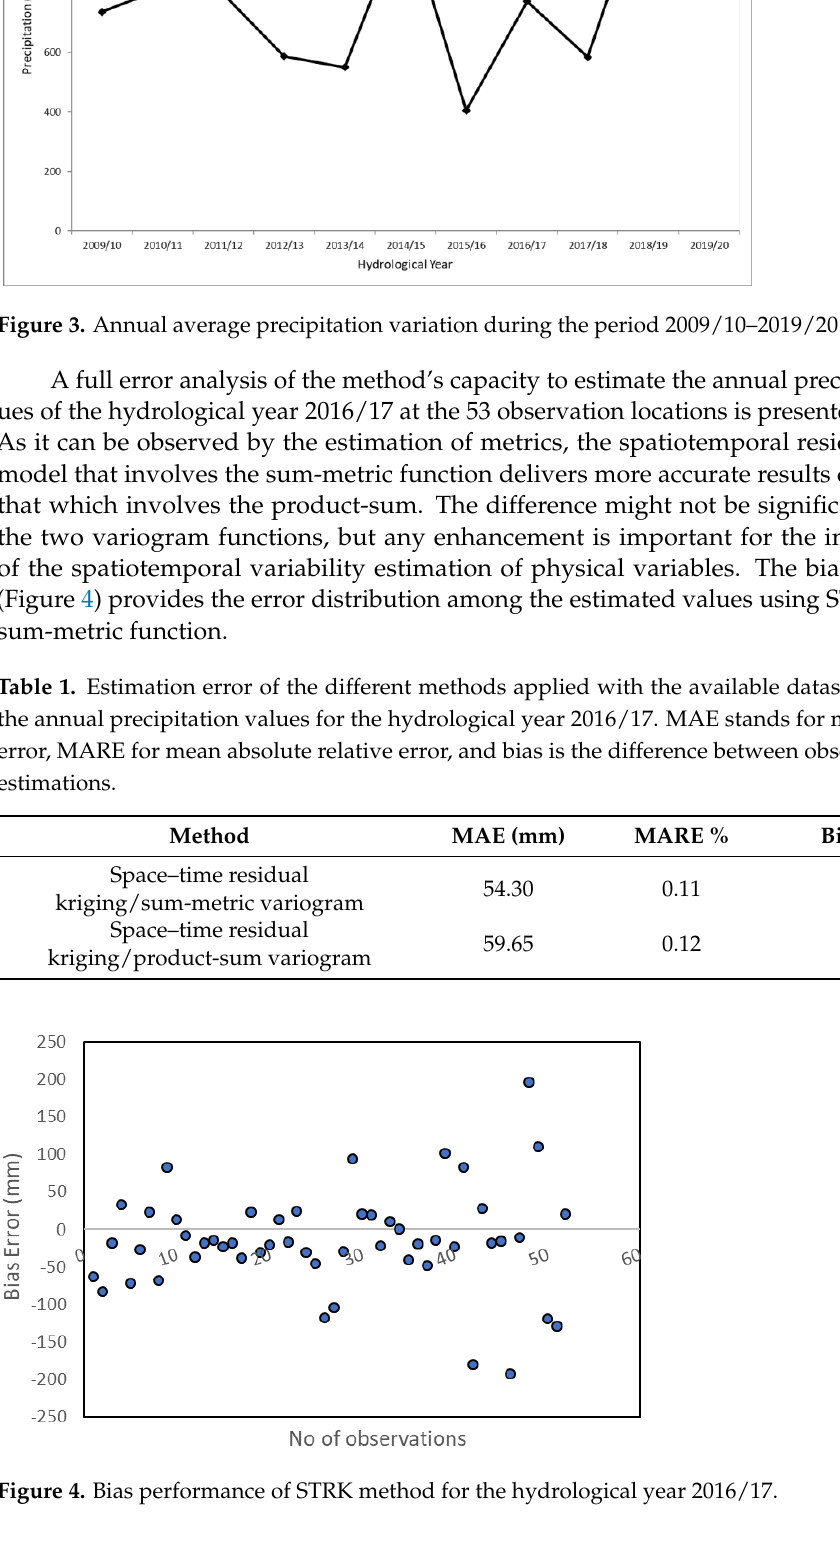
. Table 2. Sum-metric variogram models and paraments. Model